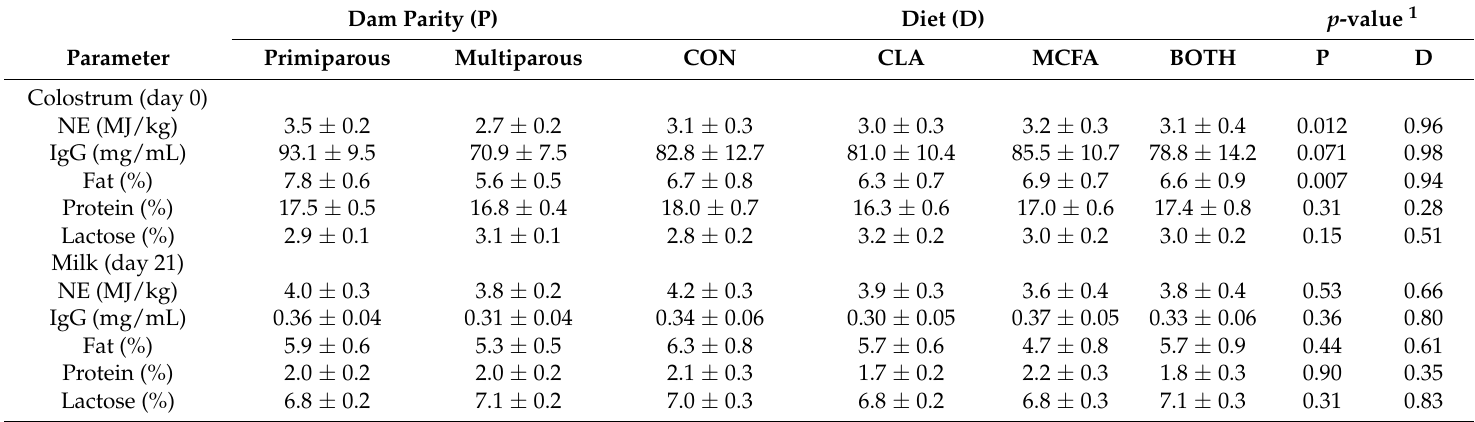
Table 5. Colostrum and milk composition of primiparous and multiparous sows when fed either a commercial control diet (CON), a diet supplemented